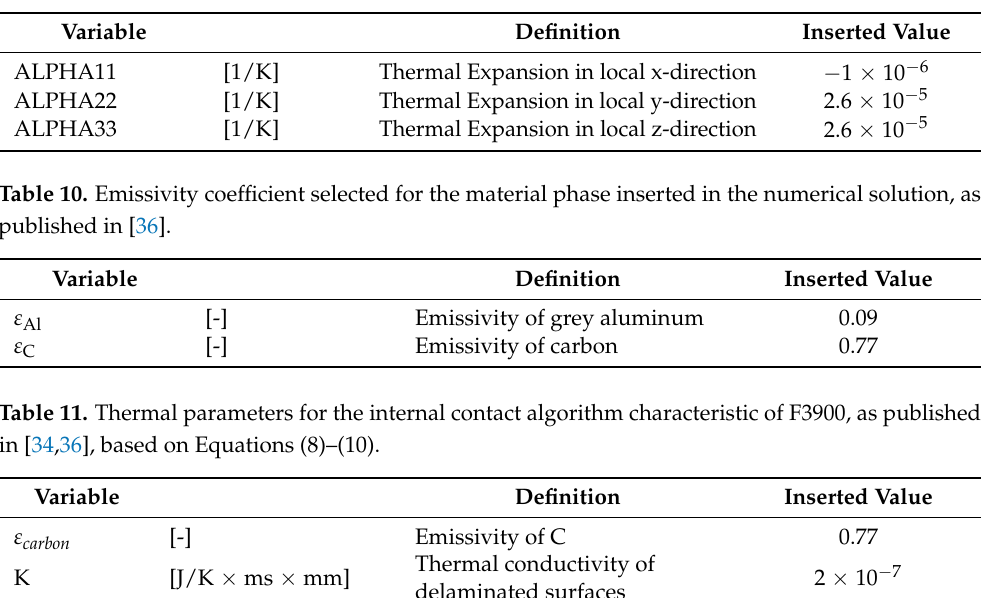
Table 9. Thermal expansion coefficient for composite T800/F3900, as published in [33].